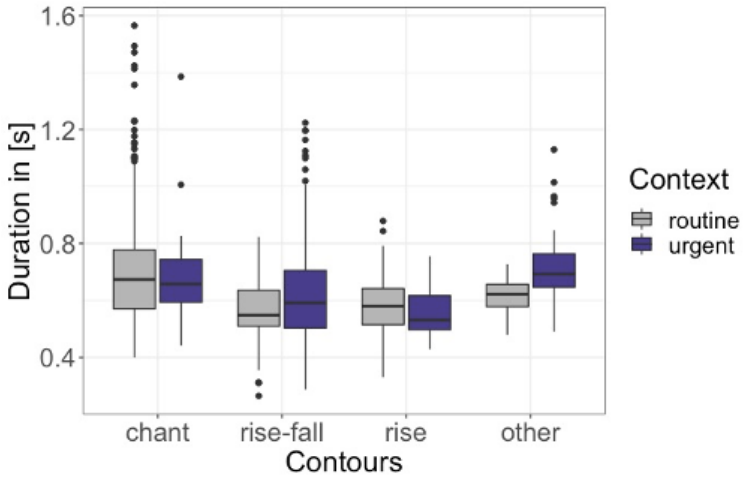
Figure 19. Word duration in the routine and urgent context across different calling melodies in MF.